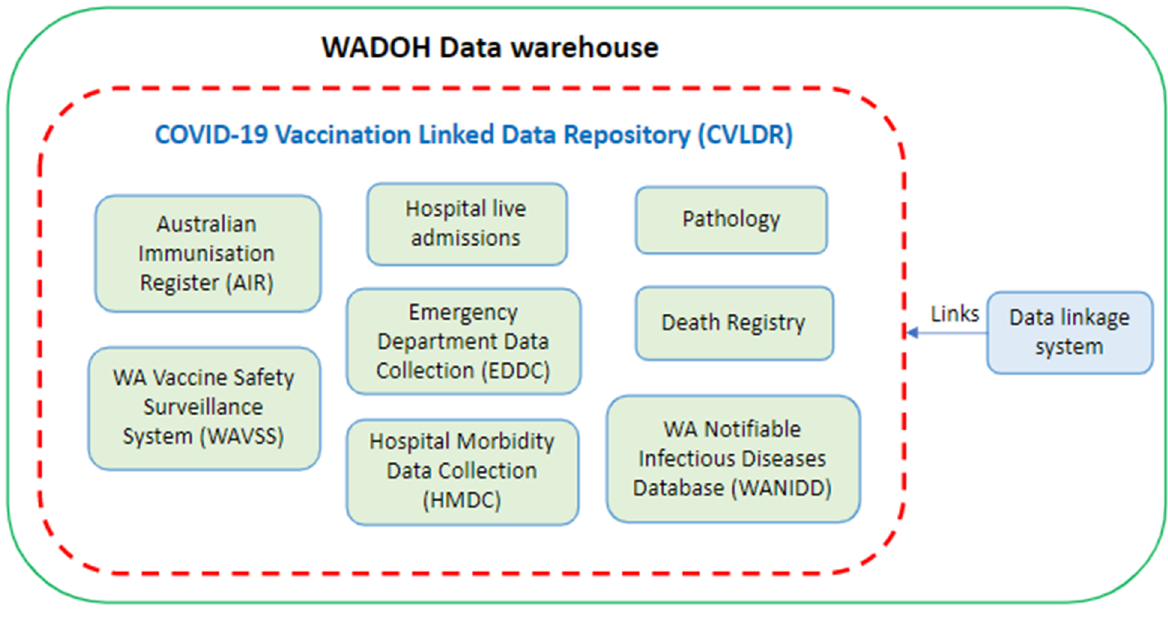
Figure 1: Visual of the COVID-19 Vaccination Linked Data Repository